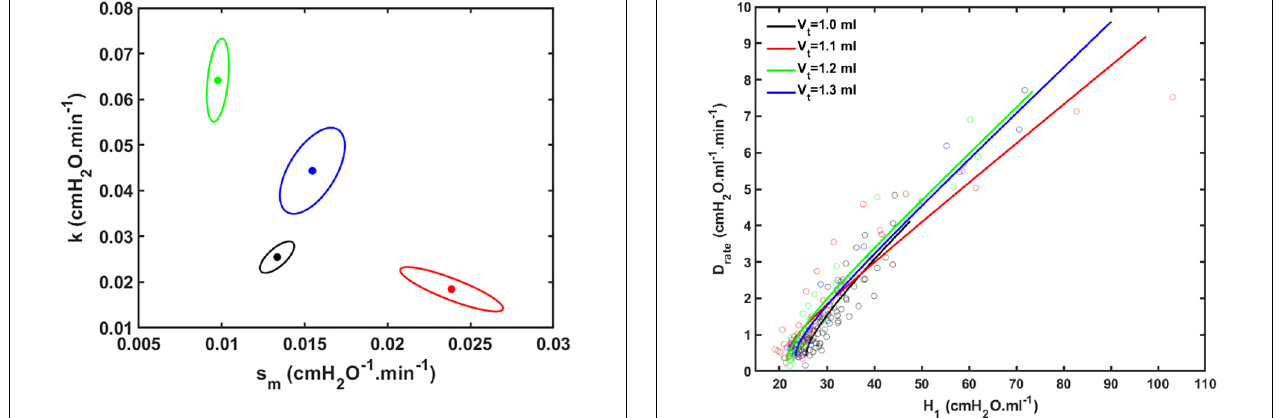
FIGURE 4 | Rate of change of lung stiffness ( D rate ) versus initial measurement of post-recruitment stiffness ( H 1 ) measured in the 4 groups of mice (symbols) together with the model fits (lines). Black: V t = 1.0 ml; Red: V t = 1.1 ml; Green: V t = 1.2 ml; Blue: V t = 1.3 ml.